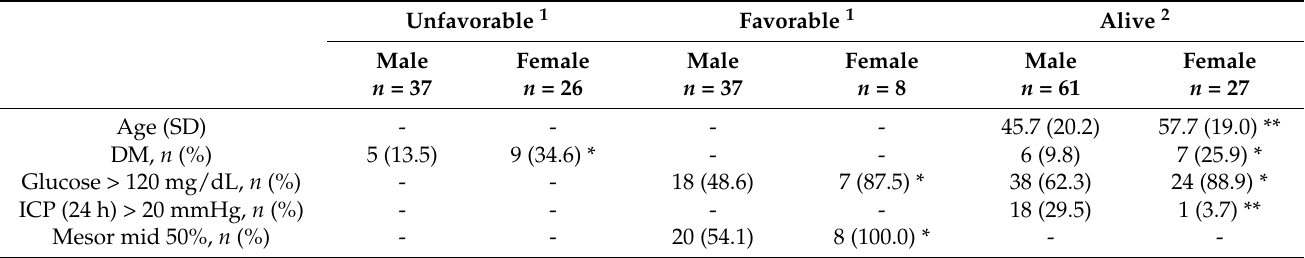
Potential predictors identified in the univariate analysis were included in the multi- variate analysis (Table 4). The functional outcome 12 months after surgery was significantly associated with age, elevated blood glucose level, initial GCS score, and the presence of brain temperature rhythm. Specifically, patients with brain temperature rhythms were 5.28 times more likely to have a favorable functional outcome 12 months after the surgery (odds ratio [OR] 5.28; 95% confidence interval [CI] 1.61–17.64). Older patients were less likely to have favorable outcomes (OR 0.94; 95% CI 0.90–0.97). Patients with a higher GCS score before surgery were more likely to have a favorable outcome (OR 1.53; 95% CI 1.21–1.93). Patients with initial blood glucose of >120 mg/dL were 0.21 times less